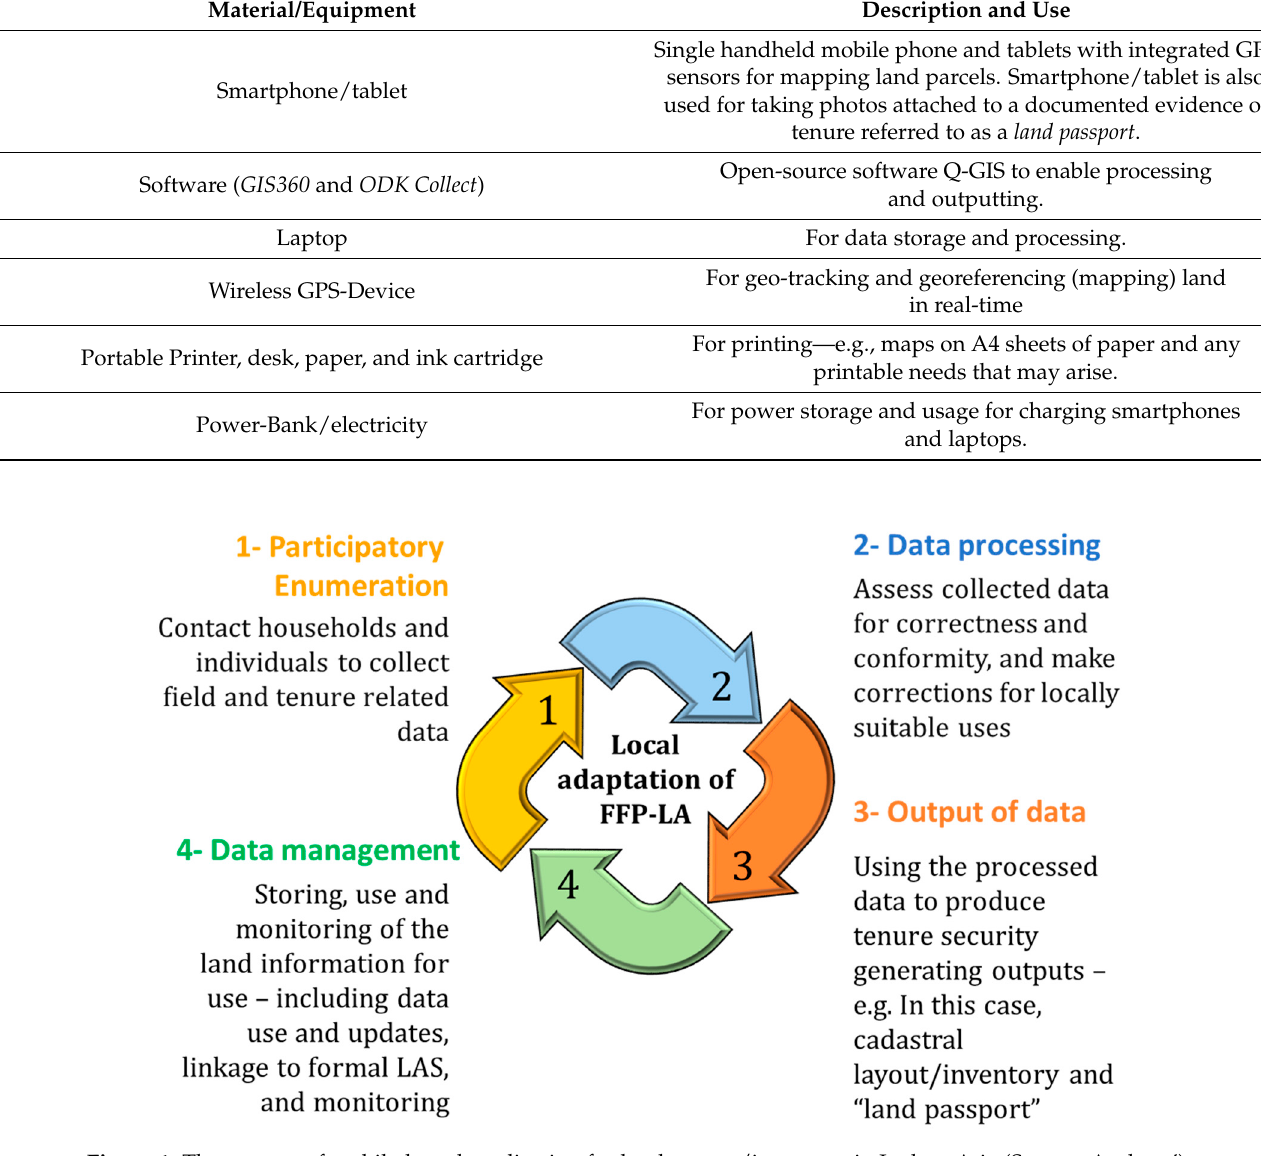
Figure 1. The process of mobile-based application for land survey/inventory in Juaben-Atia (Source: Authors’).